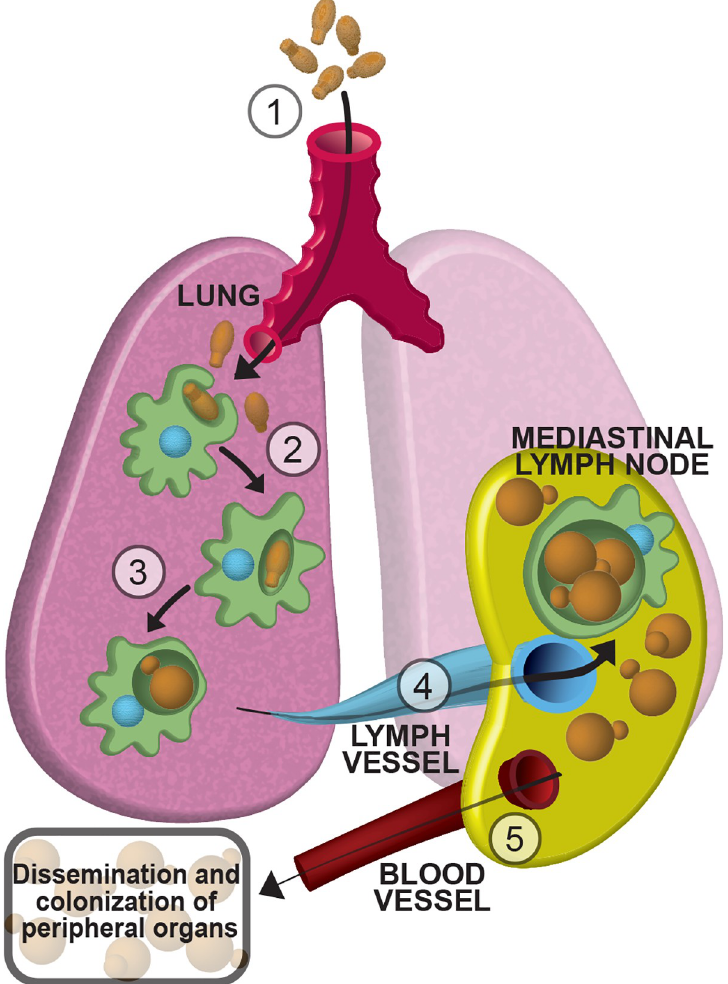
Fig 8. Model of cryptococcal spore-mediated disseminated disease. Graphical representation of our model of spore- mediated lung escape and disseminated disease: (1) spores are inhaled from the environment into the lungs where they are taken up by resident lung CD11c-positive phagocytes, likely alveolar macrophages (2). Inside phagocytes, spores are able to (3) germinate and efficiently (4) traffic to the mediastinal lymph nodes (the order of events 3 and 4 is unknown). From the lymph node, (5) Cryptococcus gains access to the blood stream, which can be used to disseminate to and colonize peripheral organs, eventually resulting in fatal CNS